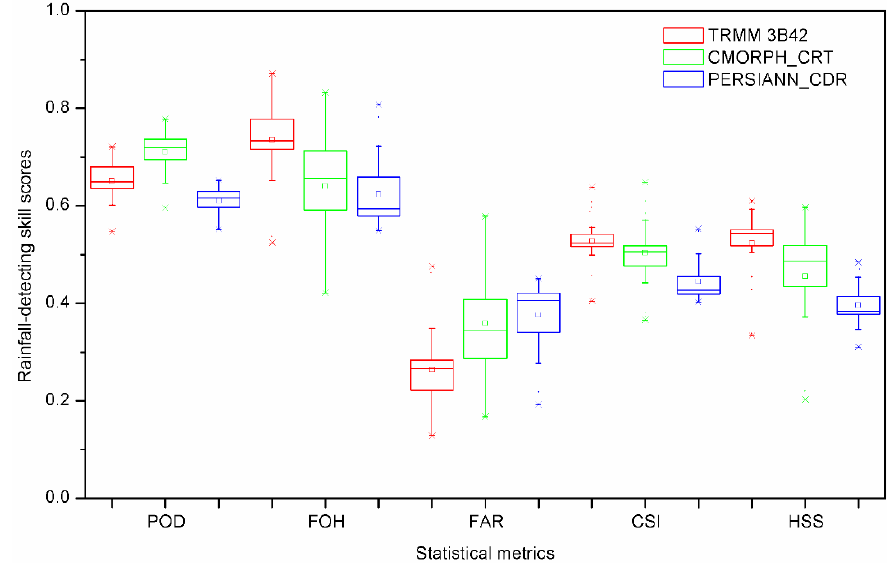
Figure 4. Box plots of rainfall-detecting skill scores for 25 rain gauges. The upper and lower edges of the large box mark the upper and lower quartiles (75% and 25%, respectively), the small box and the solid line within mark the mean and median value, and the upper and lower horizontal lines out of the large box mark the maximum and minimum, respectively.